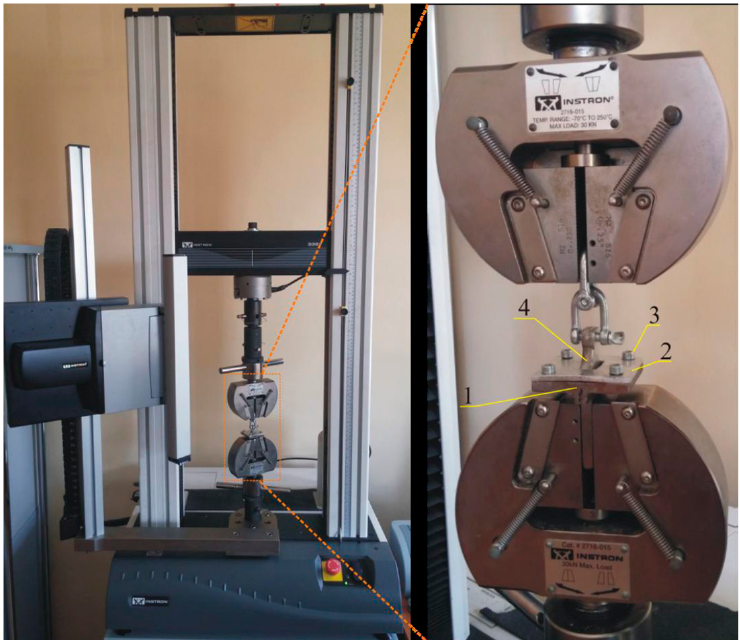
Figure 1. The clamps for testing the adhesive strength of coatings and deposited copper layers; the tested sample was mounted between the fixed base (1) and the cover (2) by clamping with screws (4), with a hole for a punch (4) in the cover (2).